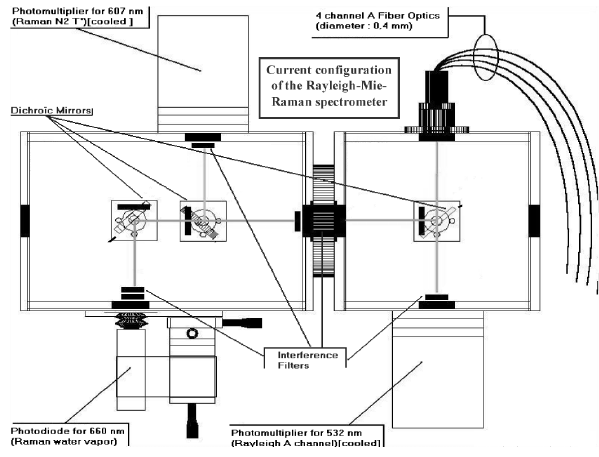
Fig. 2. Schematic representation of the current configuration of the Rayleigh-Mie-Raman spectrometer of the preliminary lidar